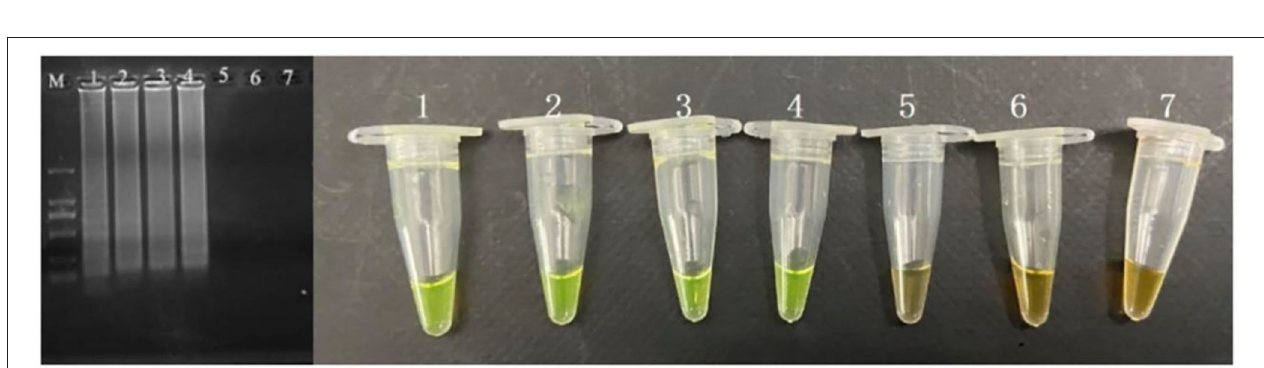
FIGURE 1 | Specificity of CPA detection for different strains with pheS genes by 1.5% agarose gel electrophoresis and mixed chromogenic agent; M-DNA marker; lane/tube 1, P. acidilactici BM-PA17927; lane/tube 2–20, non- P. acidilactici BM-PA17927 strains of E. coli , Salmonella enteric , Vibrio parahaemolyticus , Pseudomonas aeruginosa , Listeria monocytogenes , Staphylococcus aureus , and Lactobacillus casei ; lane 21, negative control.